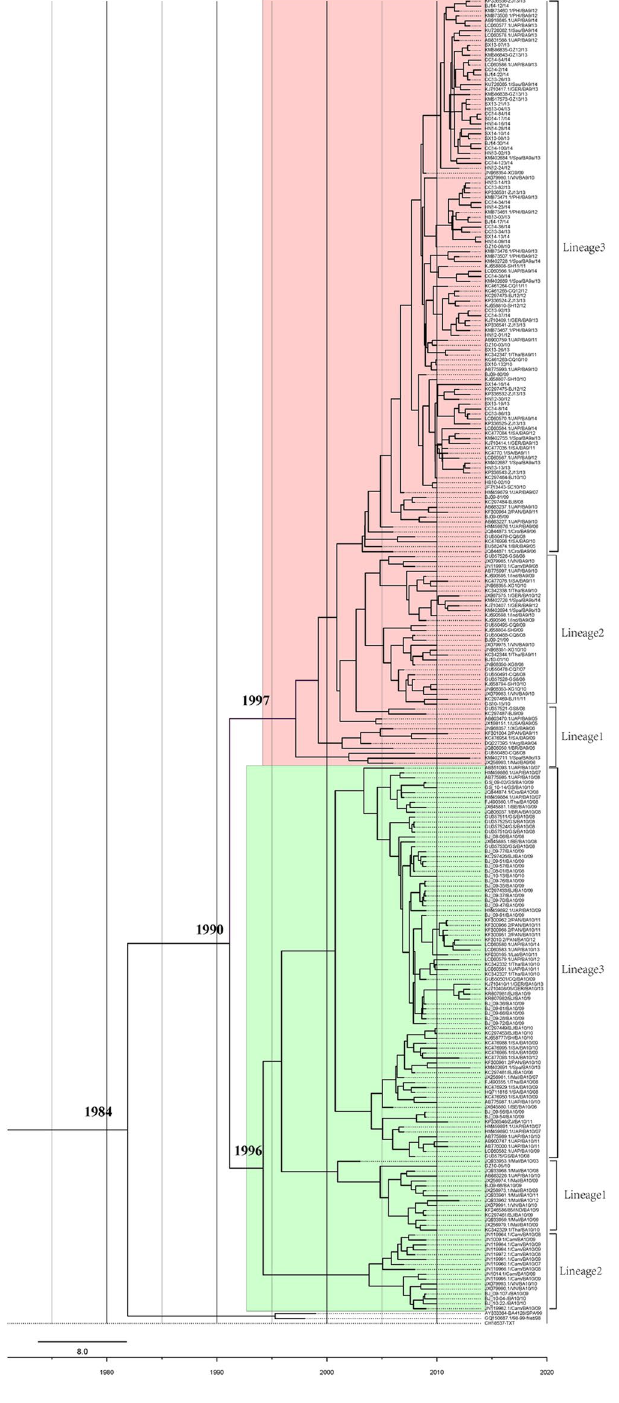
Figure 4. Maximum clade credibility tree of genotypes BA9 and BA10 of HRSVB. Sequences of the BA9 genotype were shaded in pink and those of the BA10 genotype were shaded in